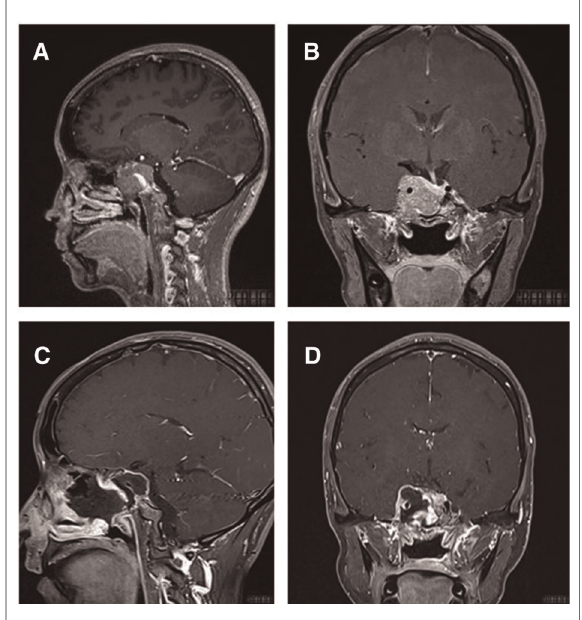
FIGURE 4 T1-weighted MRI image with contrast enhancement of a cavernous sinus pituitary tumor. ( A ) Preoperative sagittal view. ( B ) Preoperative coronal view. ( C ) Postoperative sagittal view. ( D ) Postoperative coronal view. Note in ( C ) and ( D ) the autologous fat employed intradurally to fi ll empty space within the sellar after tumor